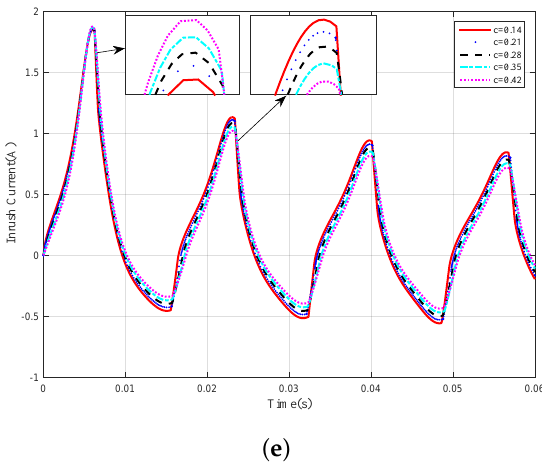
Figure 4. The impact of ( a ) M s ; ( b ) α ; ( c ) a ; ( d ) K and ( e ) c on the inrush